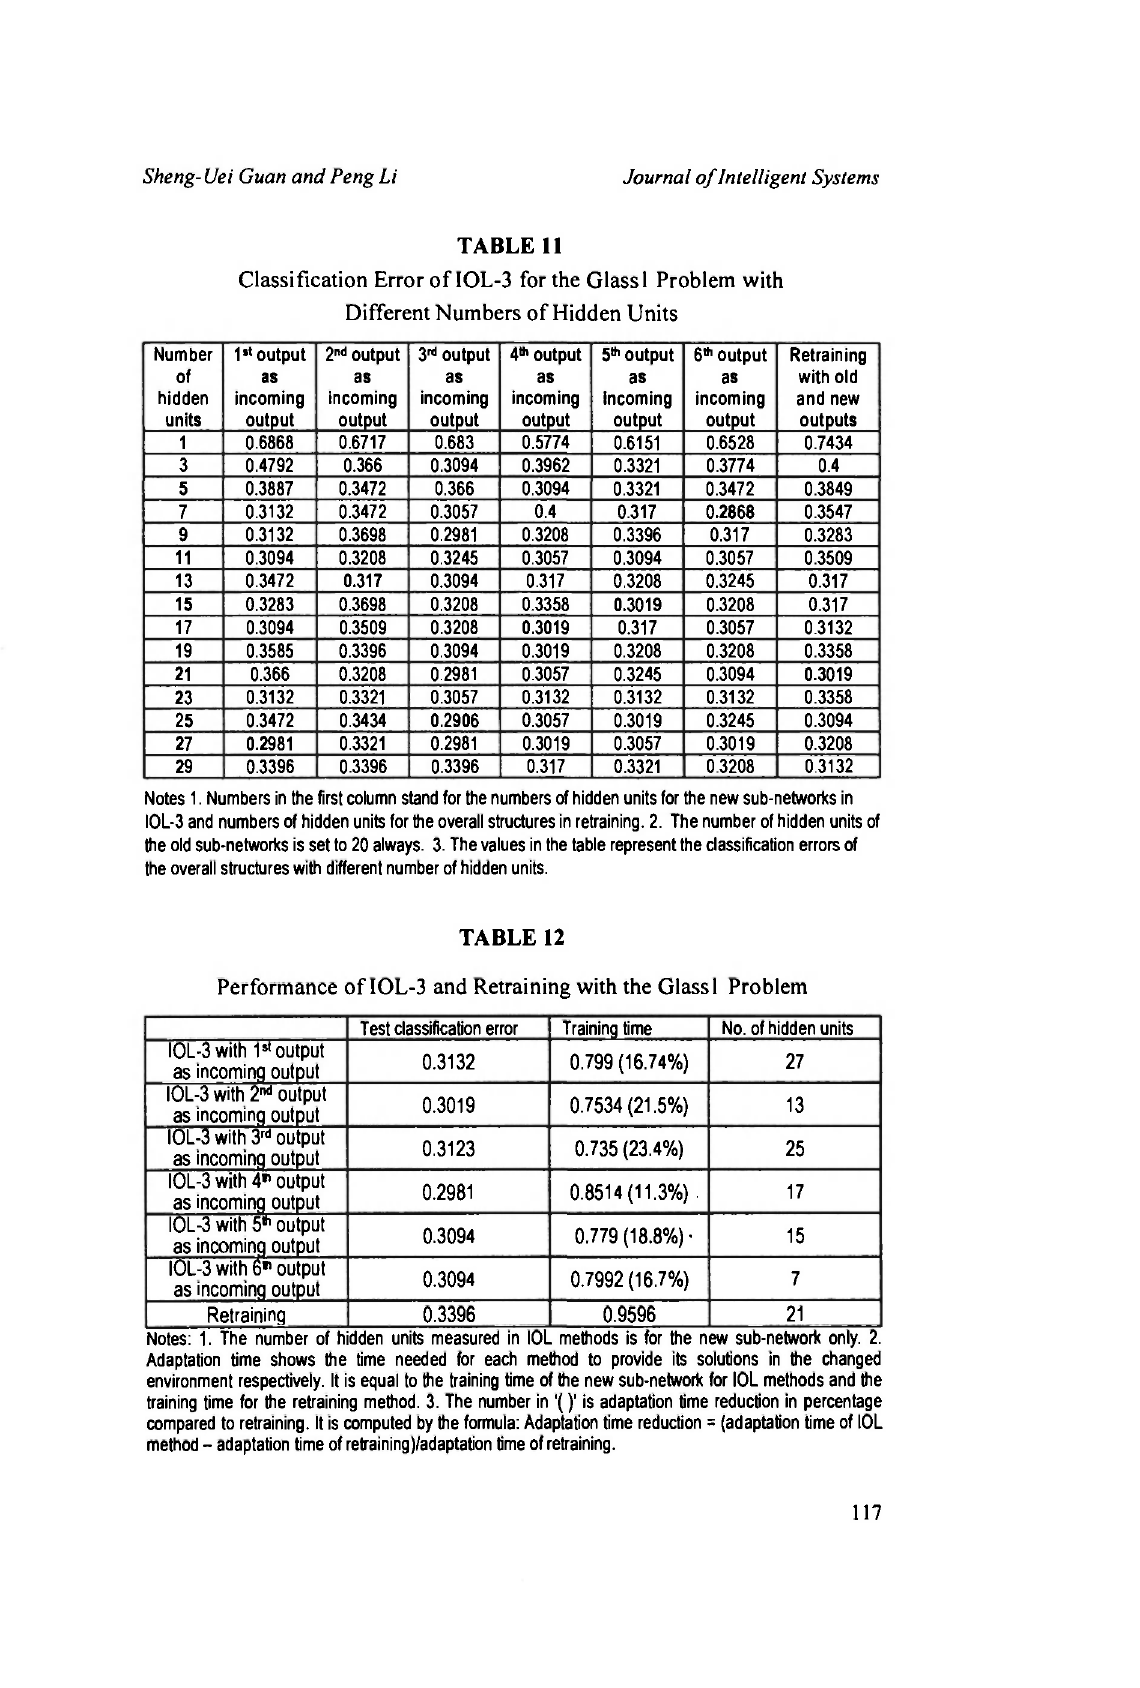
Classification Error of IOL-3 for the Glassl Problem